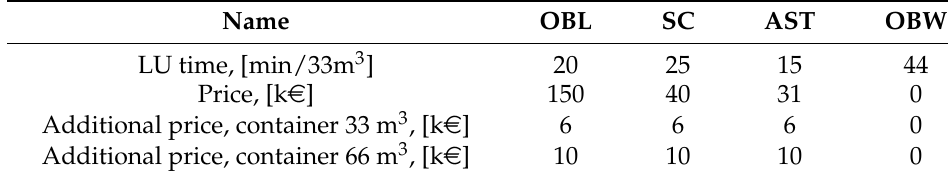
Table A7. Loading–unloading (LU) schemes data.